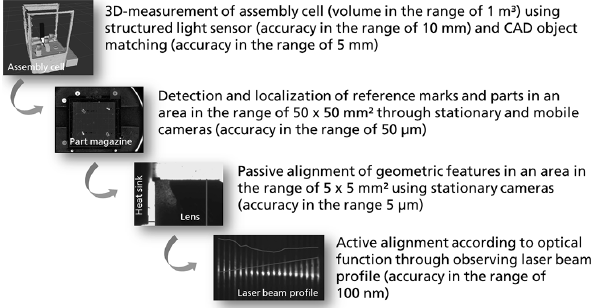
Figure 2. Chain of refined perception for self-optimizing assem- bly of micro-optical systems indicating roughly the volume or area covered by measurements as well as the measurement accuracy